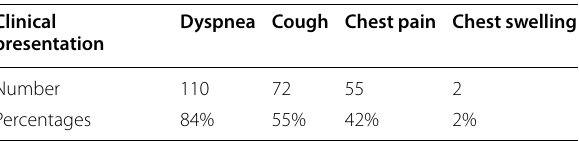
Table 1 Major presenting chest complaints of the patients in Table 3 Number and percentage of patients in the fatty